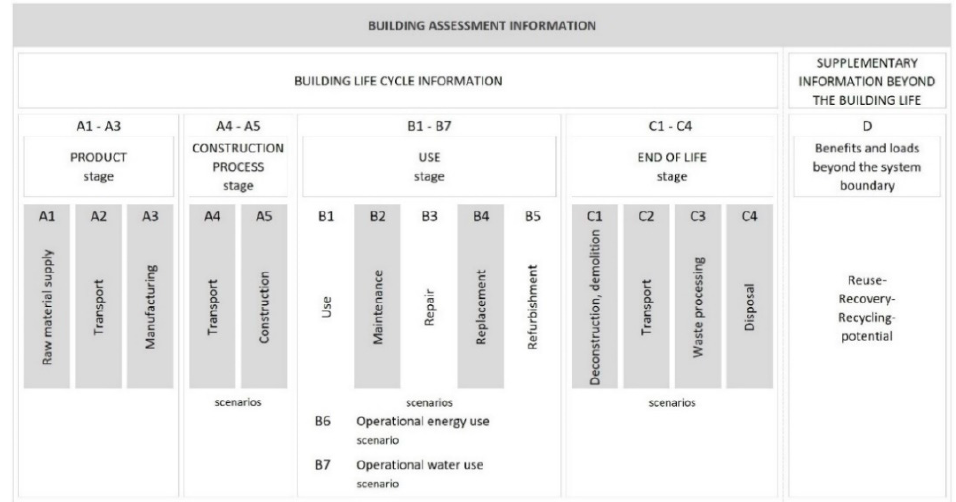
Figure 3. Overview of the life cycle stages and system boundaries in line with EN 15804 [23] and EN 15978 [24]. This study considers the information modules in the grey-colored boxes.